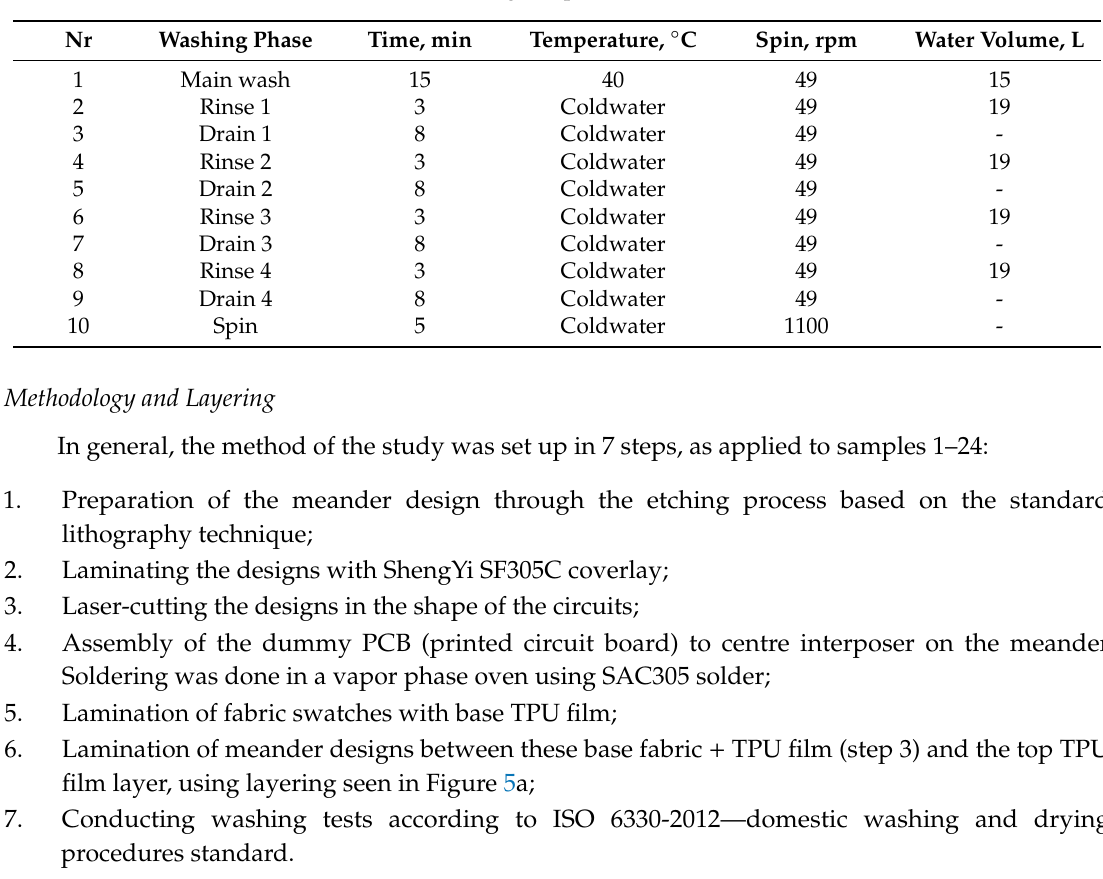
Table 3. Washing test procedure